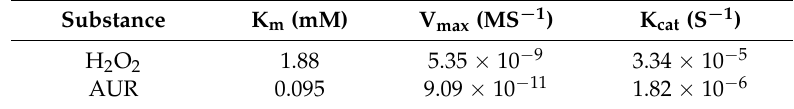
Figure 2. ( a ) Absorbance of formazan dissolved in DMSO; ( b ) Peroxidase-like activity of AuCs at pH 7.0 when the temperature varies from 25 ◦ C to 45 ◦ C; ( c ) pH-dependent peroxidase-like activity of AuCs at 37 ◦ C. Fitted curve of steady-state kinetic analyses was obtained by ( d ) altering the concentration of AUR with fixed 40 µ M AuCs and 100 µ M H 2 O 2 ; ( e ) changing the concentration of H 2 O 2 with fixed 40 µ M AuCs. Table 1. Michaelis-Menten Constant (K m ), Maximum Reaction Rate (V max ) and Catalytic Constant (K cat ) of